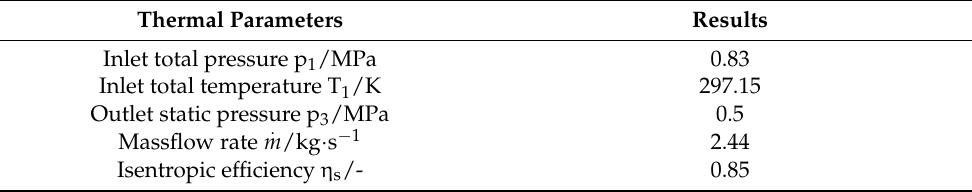
Table 1. Thermal parameters of the turbine inlet and outlet given by cycle calculation. Thermal Parameters